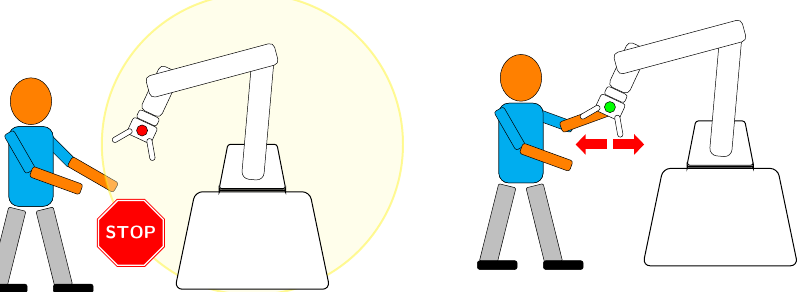
Figure 4. Illustration of the first levels of robot safety standards, as defined in norms ISO 10218-1 and 10218-2: the “Safety-rated monitored stop” on the left and the “Hand guiding” on the right.